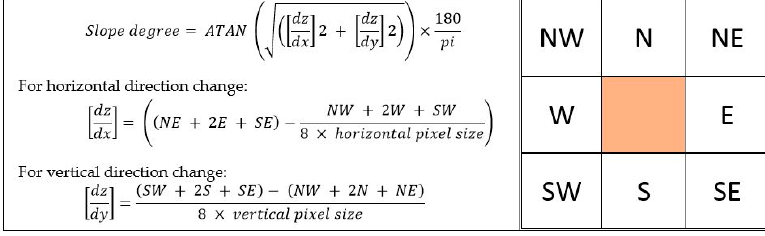
Figure 5. Slope calculation